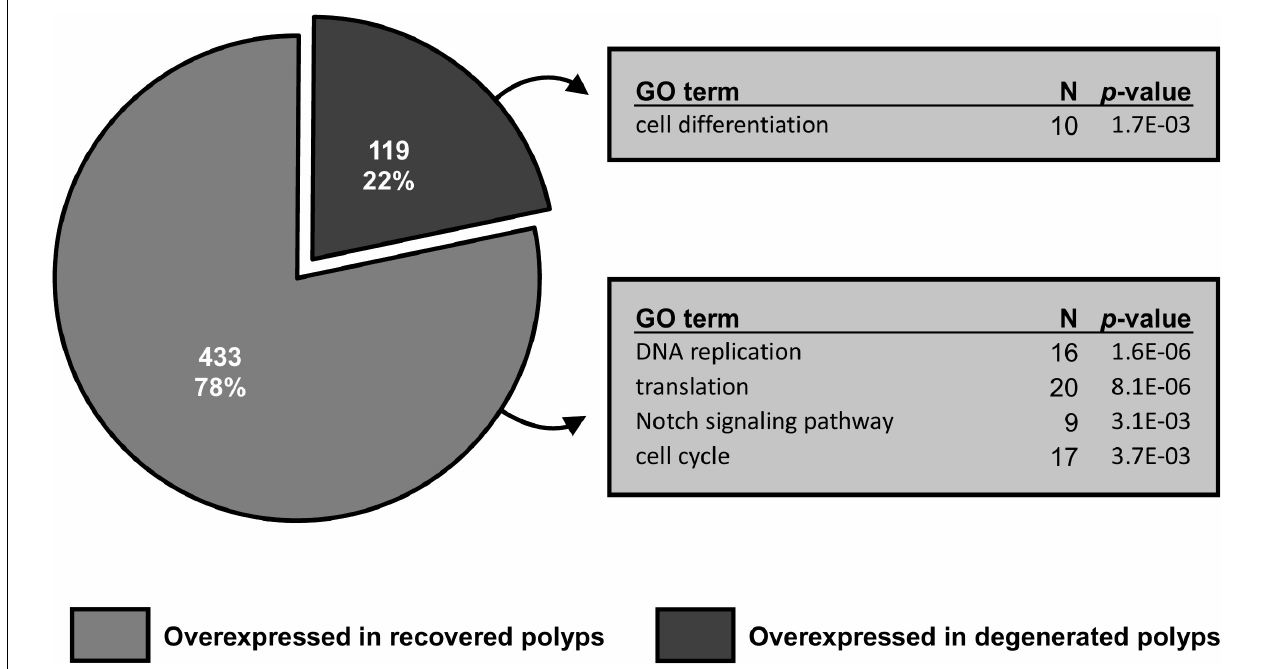
FIGURE 6 | Gene differential expression (DE) analysis of recovered and degenerated polyps at day5 post-bail-out. Numbers of differentially expressed genes (DEGs) overexpressed in each polyp morphotype are displayed. Selected biological processes significantly overrepresented ( p < 0.005) in gene ontology (GO) enrichment analysis and the number of unique genes in each GO category are